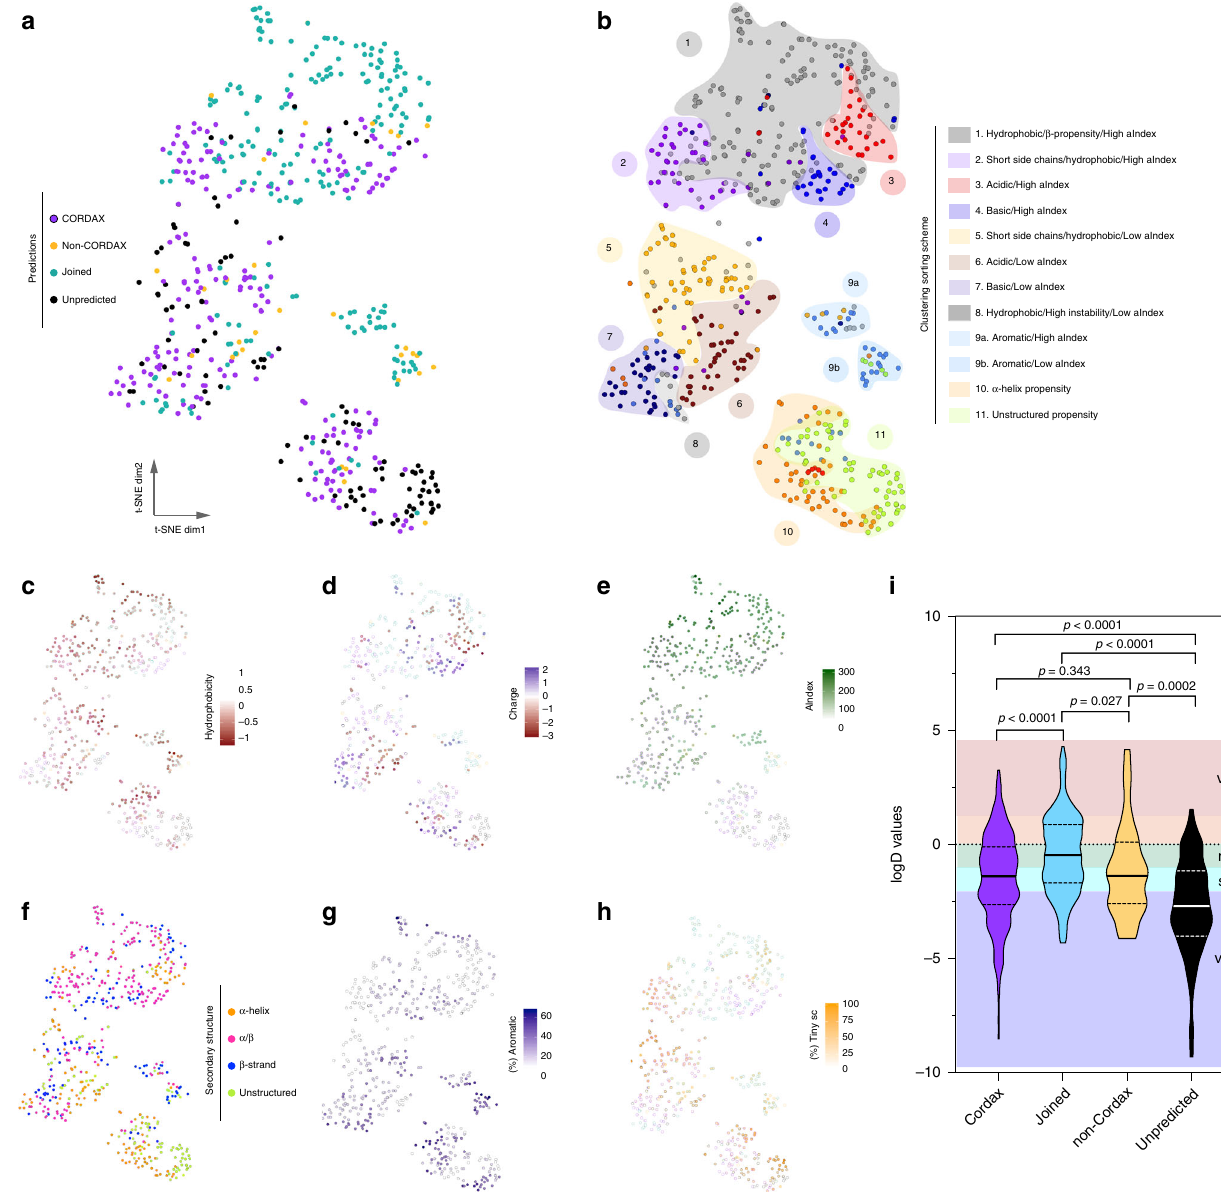
Fig. 6 t-SNE 2D-representation of the known experimentally determined amyloidogenic sequence space. a State-of-the-art sequence-based methods predict amyloid sequences, with (shown in cyan) or without Cordax (shown in yellow), that are grouped together in a major landing cluster and two islands. Cordax predictions (shown in purple) transgress towards areas of amyloid-forming sequences that remain undetected by most methods (shown in black). b Clustering of the t-SNE map using basic physicochemical properties and amino acid composition of the amyloid peptides. Each data point is colour-coded based on the sorting scheme shown in the legend and background areas are used to pinpoint the major clusters of each de fi ned category. The clustering scheme was de fi ned by characterising the t-SNE map using peptide c hydrophobicity, d net charge, e aliphatic index, f secondary structure propensity and percentage content of g aromatic or h short residue side chains. i Partition coef fi cient analysis reveals that APRs identi fi ed by Cordax are primarily soluble sequences compared to easy to identify sequences of joint prediction. On the other hand, APRs that remain hard to detect are characterised by higher solubilities. Solubility regions (vi very insoluble, i insoluble, n neutral, s soluble, vs very soluble) are shown as coloured backgrounds. Signi fi cant differences were computed using one-way ANOVA with multiple comparison. Violin plots represent the kernel probability densities of the data with the median, upper and bottom